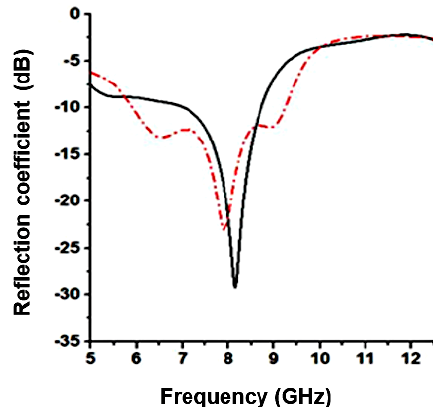
Figure 4. Simulated and measured return loss of the designed flexible antenna at 42% concentration of nickel.